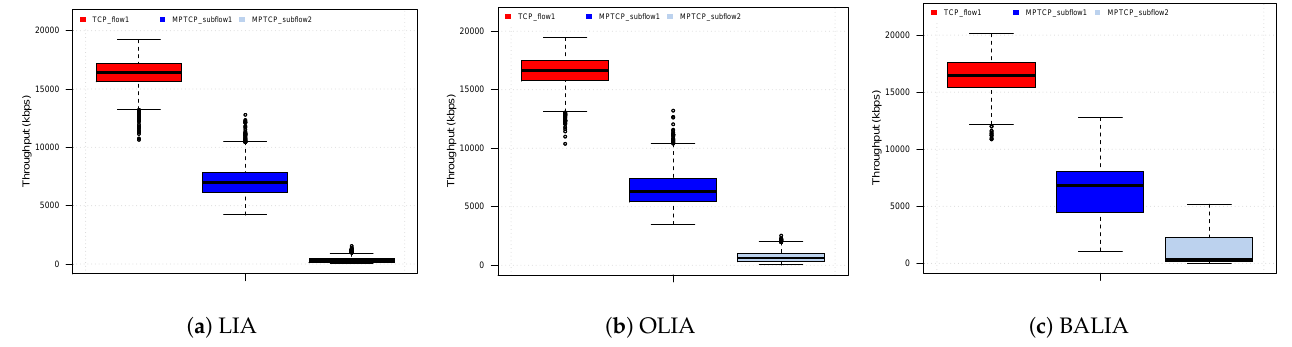
Figure 21. LIA, OLIA and BALIA Throughput Share-Shared Paths with RTT1 = 50 ms and RTT2 = 100